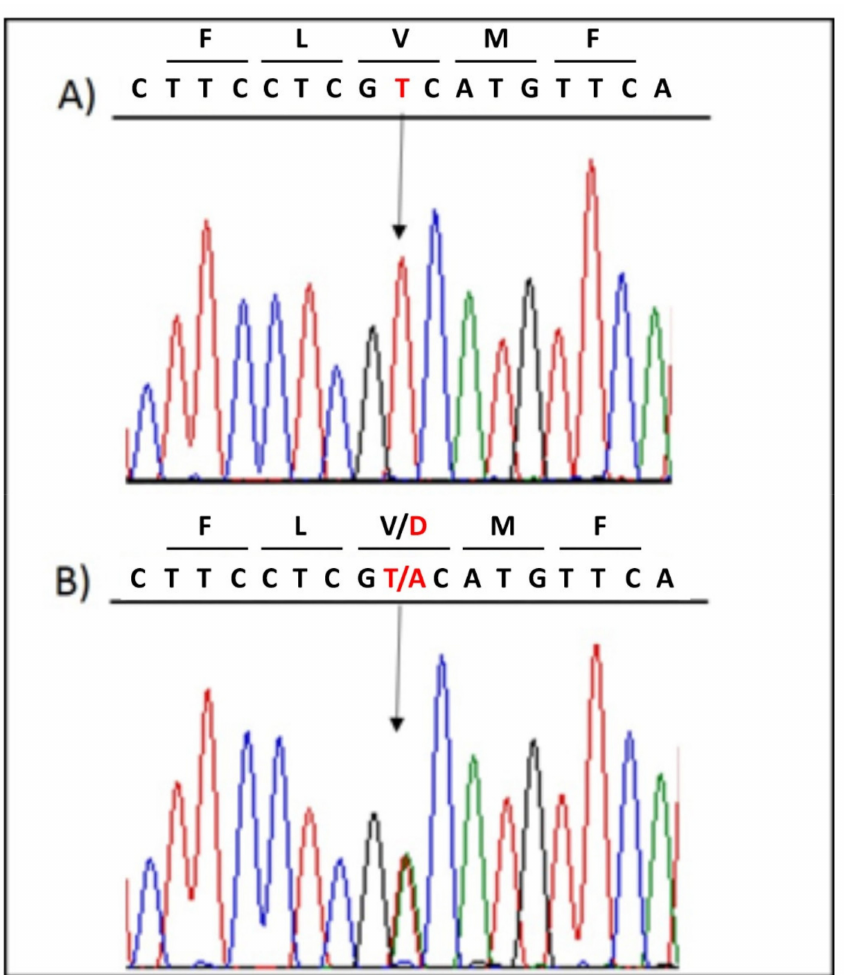
Figure 3. Post-NGS Sanger confirmation of the presence of the heterozygous variant SCN5A c.5000 T>A. ( A ) Direct sequencing electropherograms show the wild-type sequence in a family member. ( B ) The presence of the single nucleotide variant in the proband is denoted by an arrow. The first row of letters in each panel indicate the amino acid that is specified by the codon